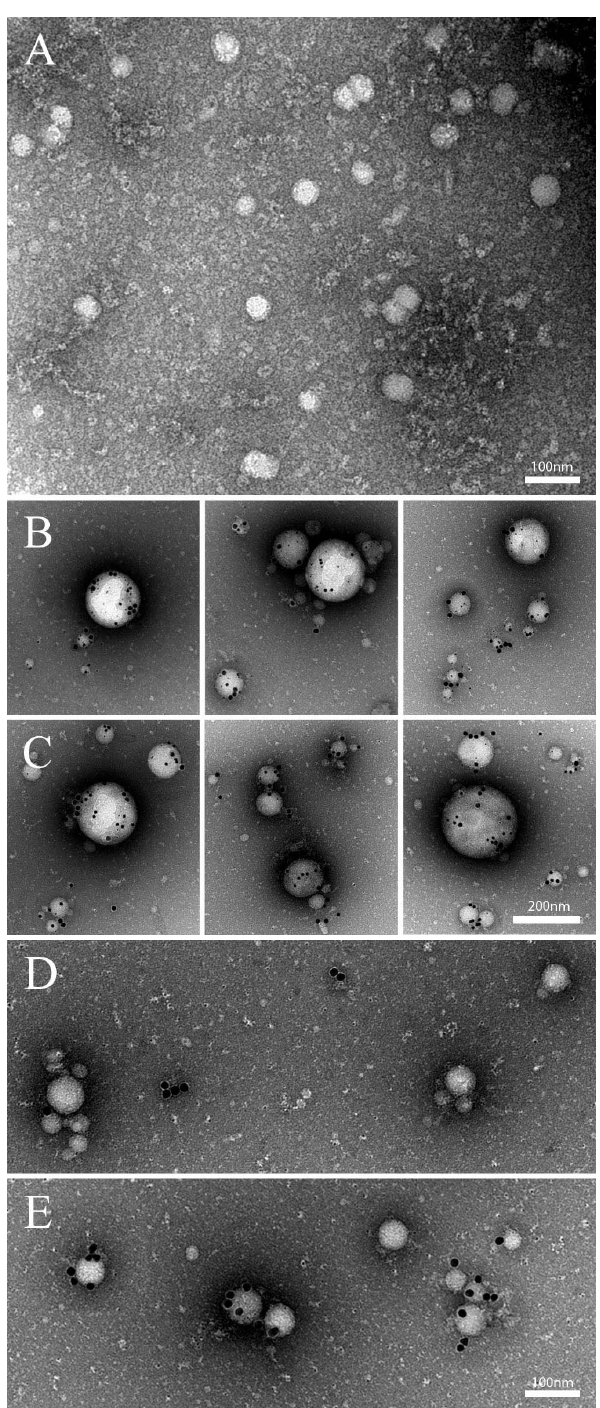
Figure 1. Transmission electron micrographs of isolated STBMs. The TEM panel (A) shows a selection of the 150K control STBMs, prior to gold-labelling. The STBMs were mixed with gold- labelled antibodies, as described in the Materials and Methods section, in two preparations. In the first preparation, STBMs shown in panels (B, control) and (C, Hb perfusions), were treated with antibodies against TF, CD63 and hsa-mir-222 labelled with colloidal gold of different sizes; CD63 (30 nm colloidal gold), TF (15 nm) and mir-222 (5 nm). Panel (B) shows the 150K control STBMs which are similar to the 150K Hb STBMs (C) in regards to the number of vesicles and their size. The 150K control STBMs (B) contain more mir-222 than 150K Hb STBMs (C). For